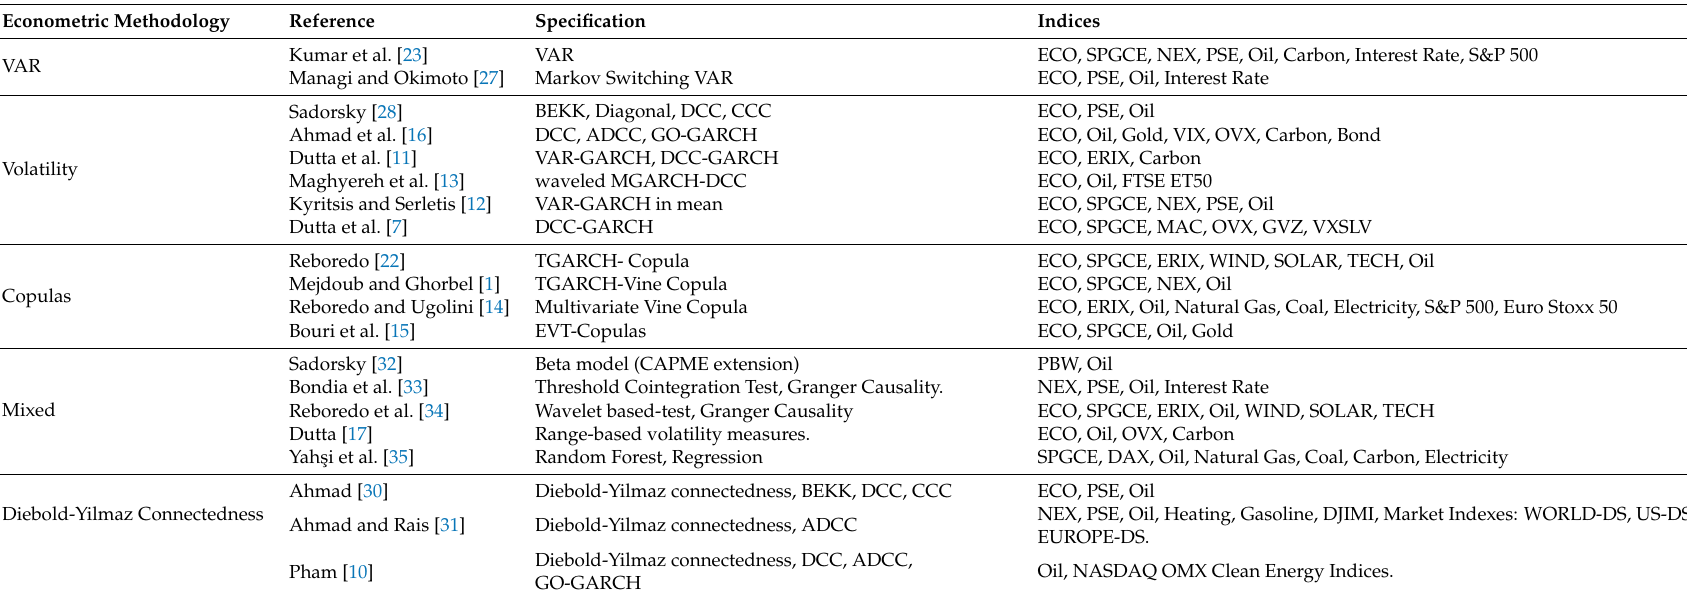
Table 1. Methodologies and indices used for empirical analyses in different